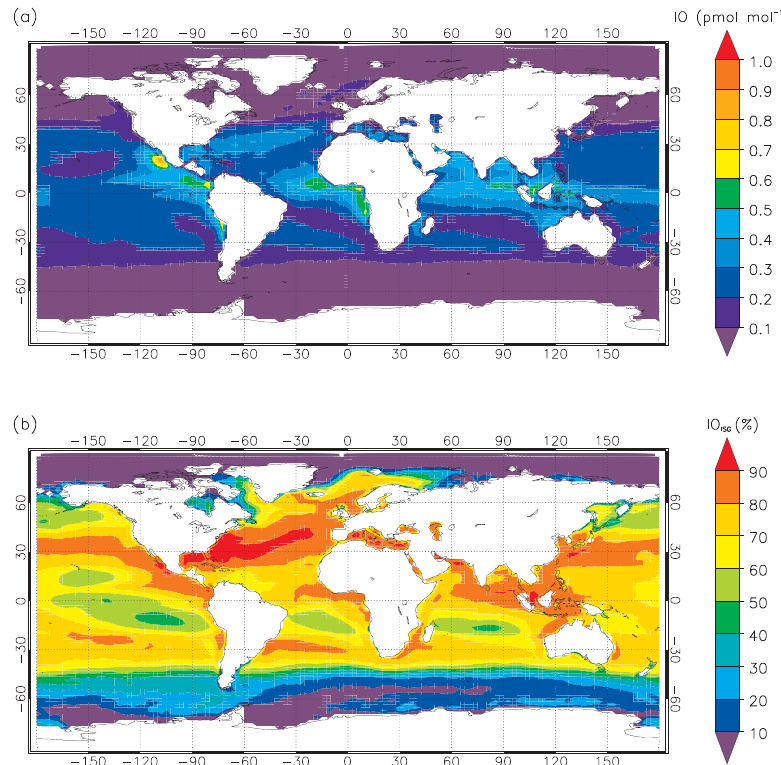
Figure 6. Simulated IO in the global marine environment (annually averaged). (a) Geographical distribution of the total IO budget in the MBL (i.e. IO ISG + OSG ), in units of vmr (pmolmol − 1 ). (b) Percentage contribution of the ISG emissions to the budget of IO in the global